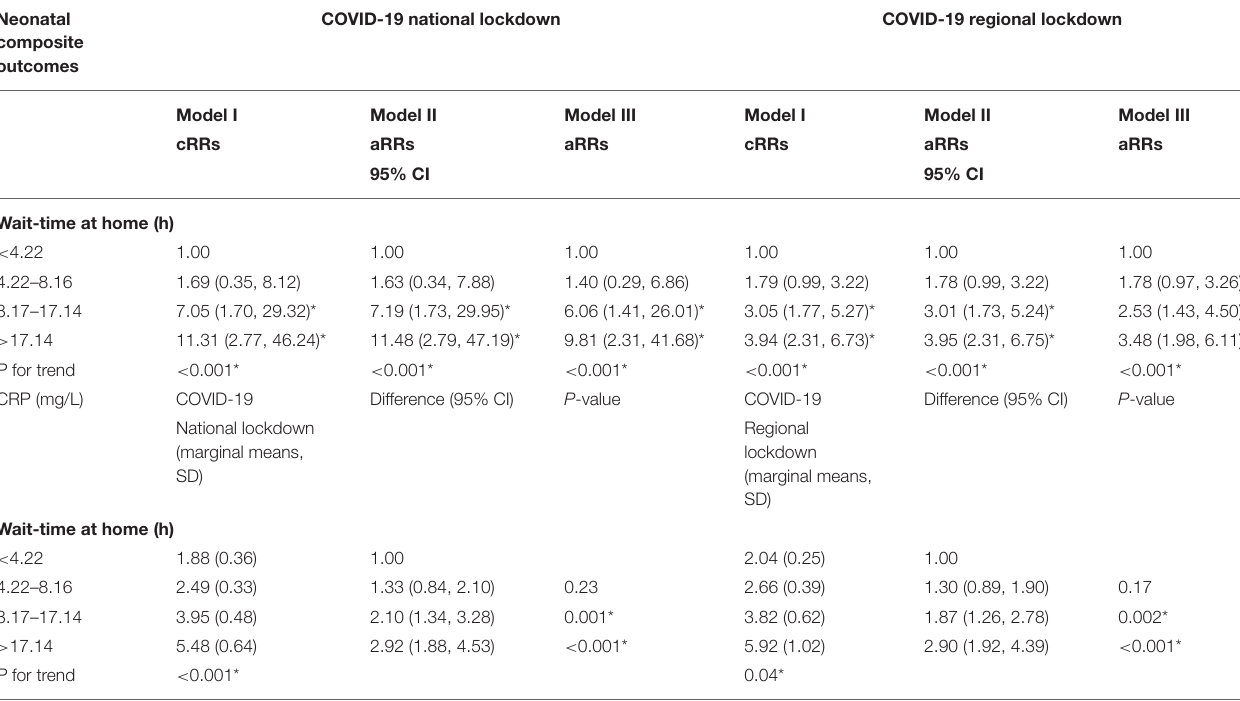
TABLE 3 | Association between PROM wait-time at home and relative risks of neonatal complications or CRP values. Neonatal composite